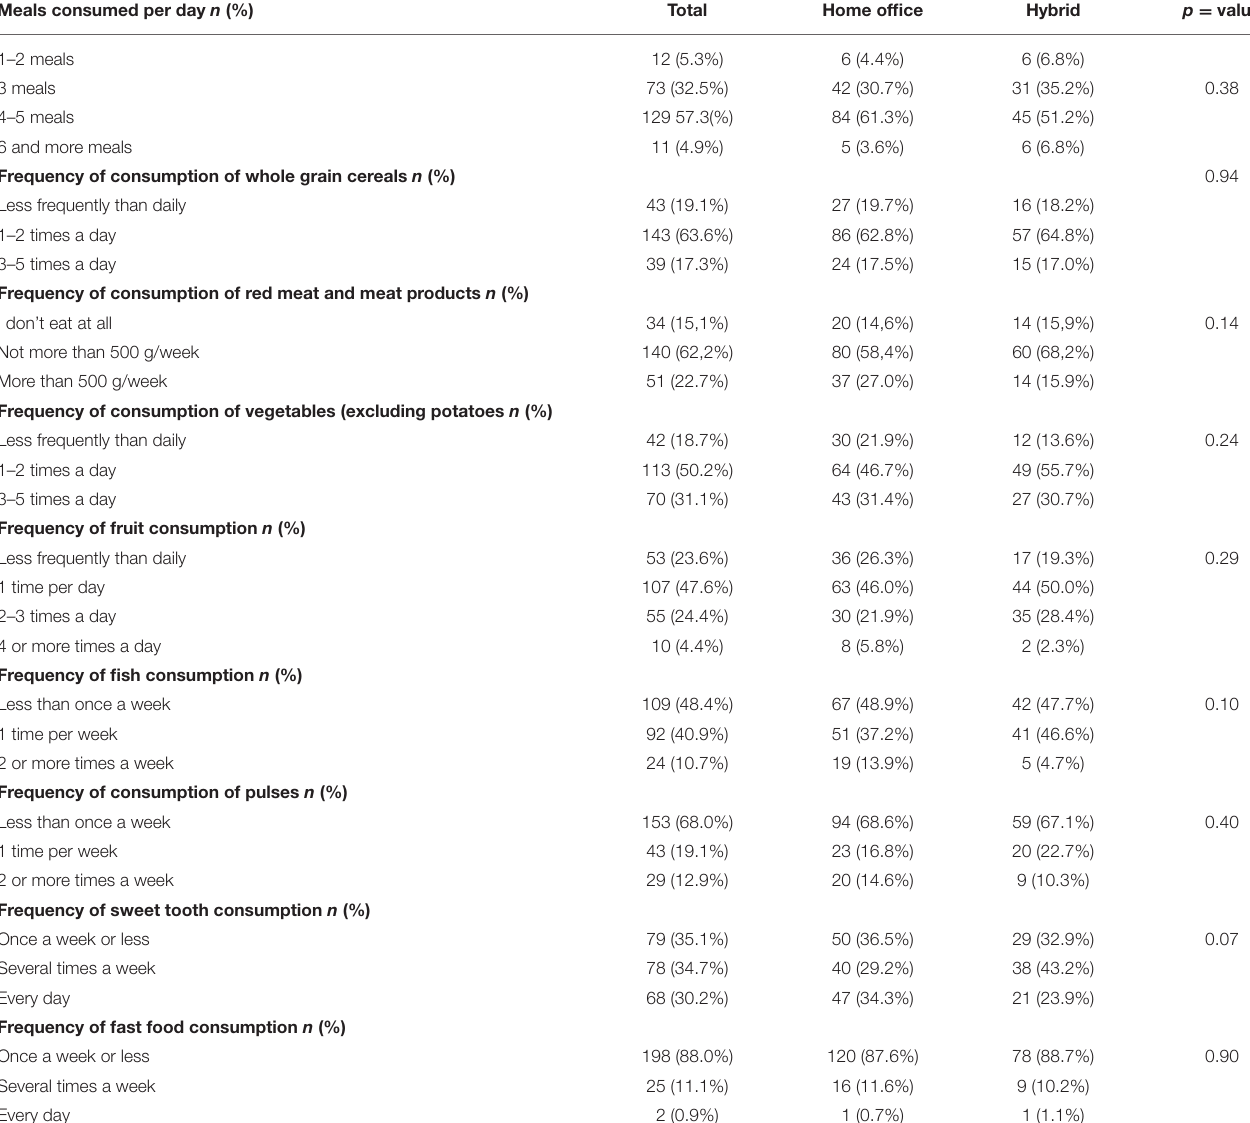
TABLE 2 | Eating behaviors while working remotely during the COVID-19 pandemic (n = 225). Meals consumed per day n